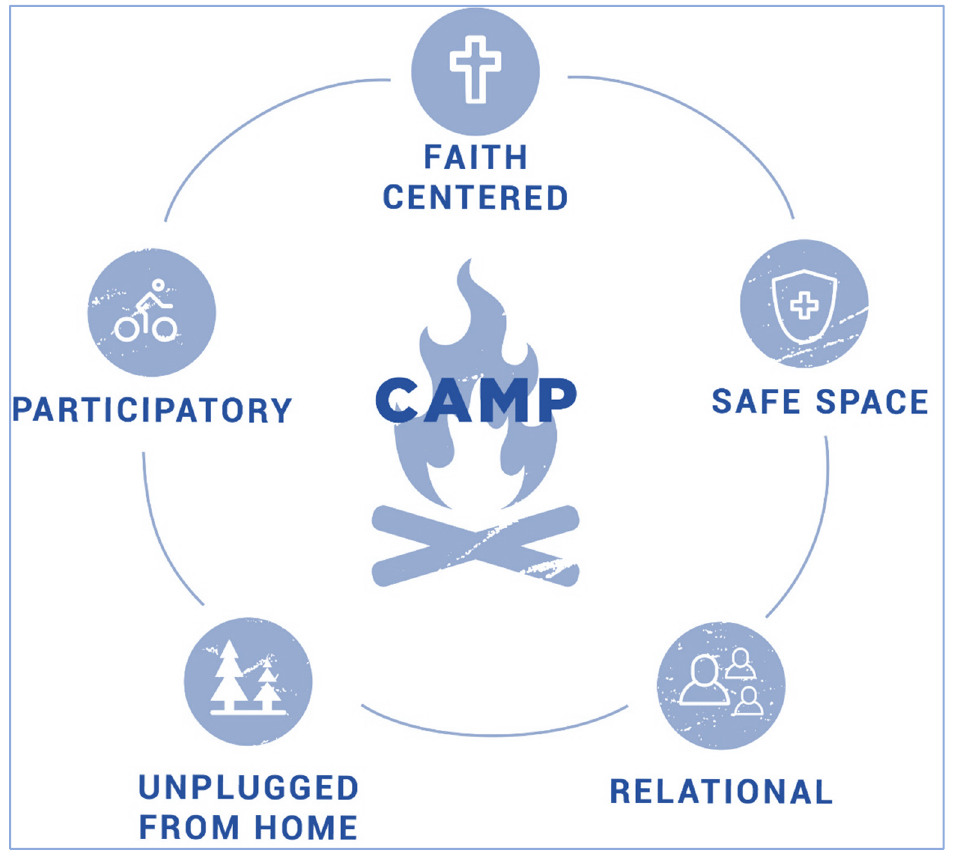
Figure 1. Five Fundamental Characteristics of Christian Camp